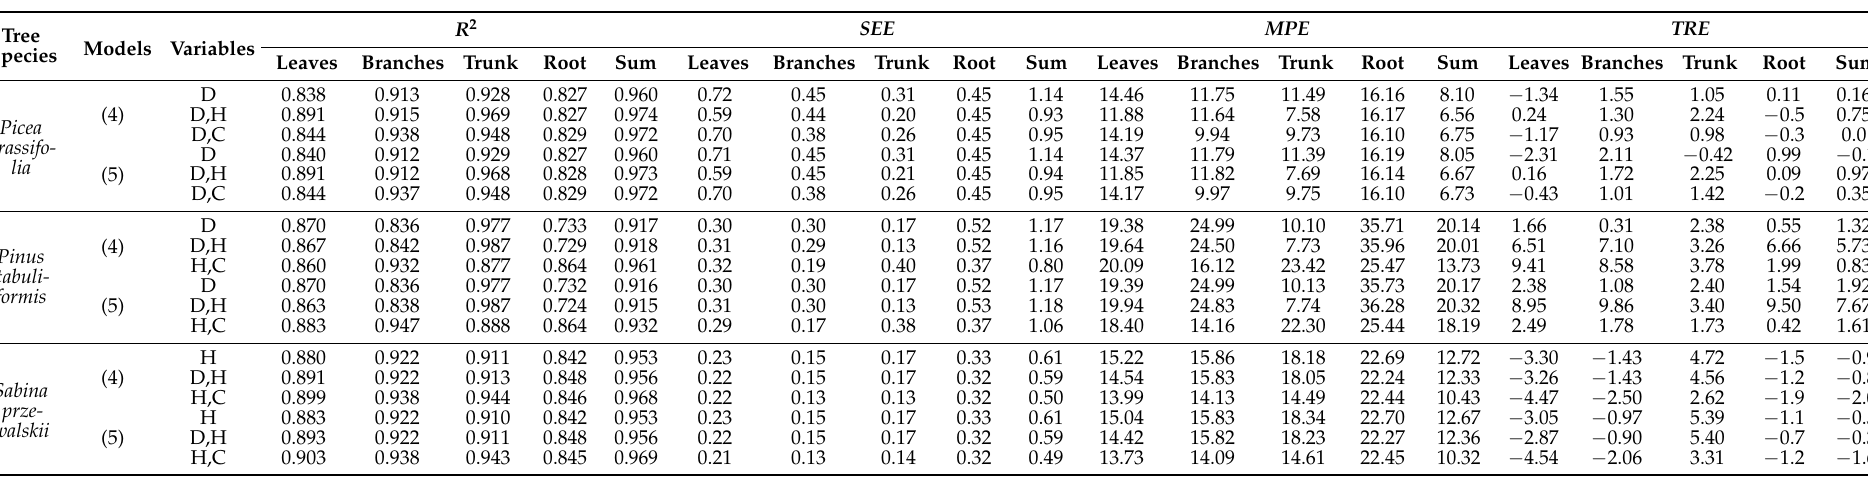
Table 5. Evaluation indicators of two compatible models estimating the total biomass and biomass of each component of three tree species. Tree